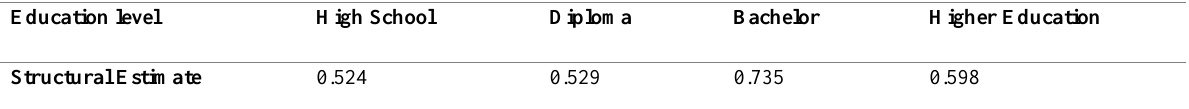
Table 4: Relationship among, number of alternatives forgone and post-purchase regret based on the education level Education